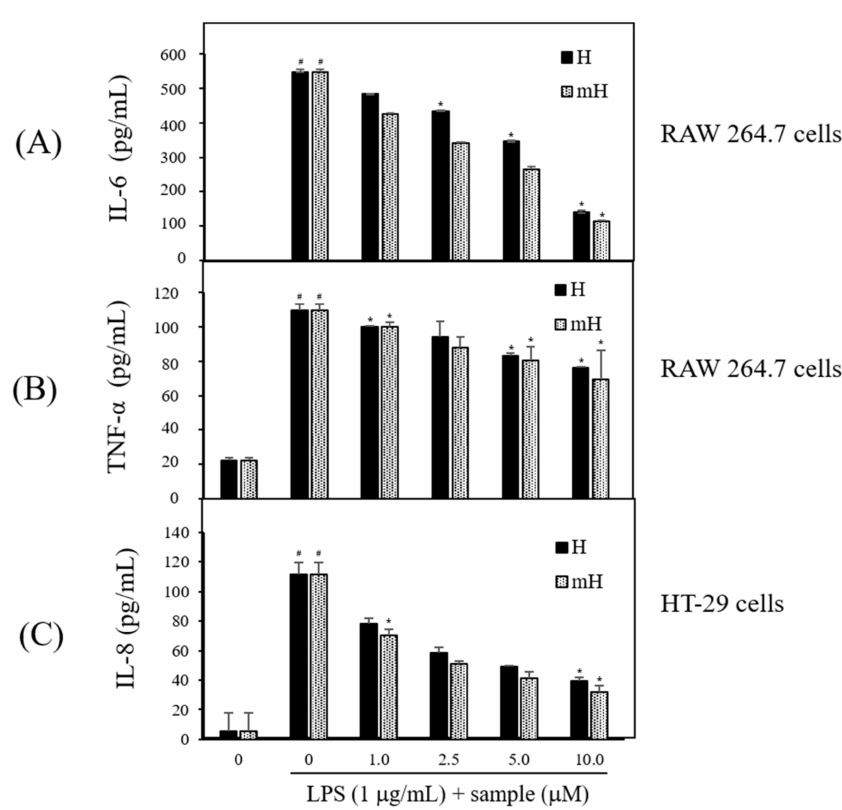
Figure 6. Effects of H and mH on production of proinflammatory cytokines. Cells were pretreated with H and mH for 1 h and then stimulated with LPS (1 µ g/mL) for 24 h. Levels of interleukin (IL)-6 ( A ); tumor-necrosis factor (TNF)- α ( B ); and IL-8 ( C ) were determined by ELISA in culture media of RAW 264.7 (IL-6, TNF- α ) and HT-29 cells (IL-8), respectively. Each determination was made in triplicate. Data are presented as means ± SD. # p < 0.05 vs. control; * p < 0.05 vs. LPS-treated